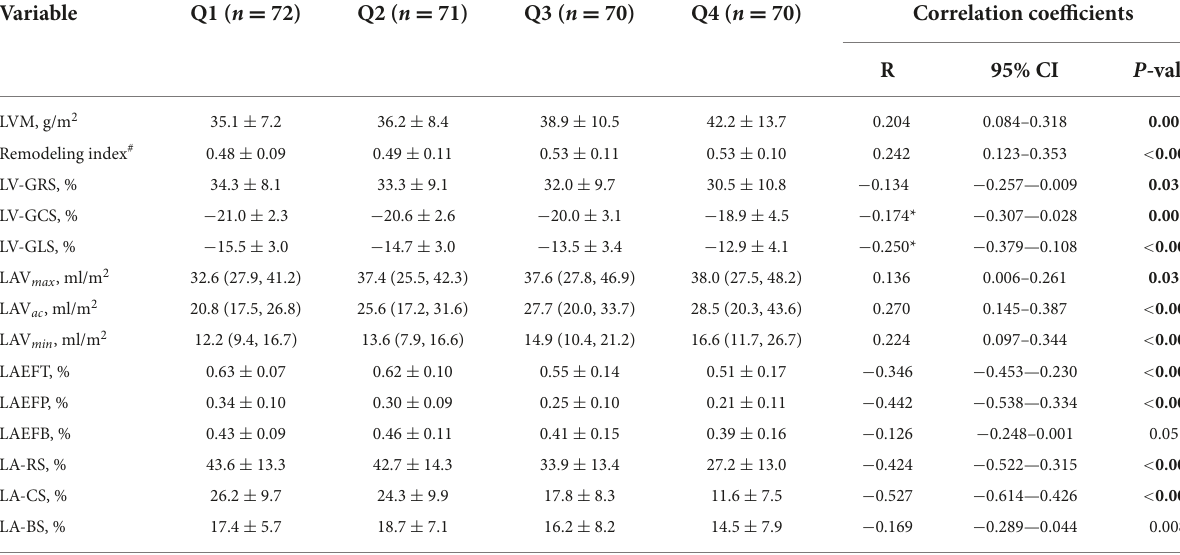
TABLE 2 Cardiac structural and functional parameters by cardiac magnetic resonance (CMR) and their correlations with epicardial adipose tissue (EAT)